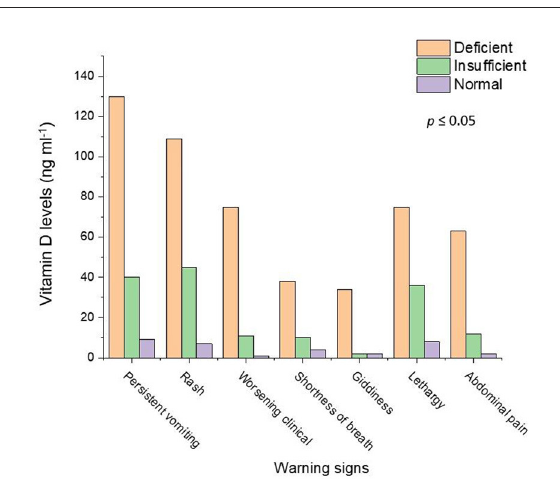
FIGURE1 Relationship of the dengue patients with warning signs and vitamin D levels. Light salmon color represents vitamin D deficiency, Light green color shows vitamin D insufficiency and violet color depicts the normal level of the vitamin D.